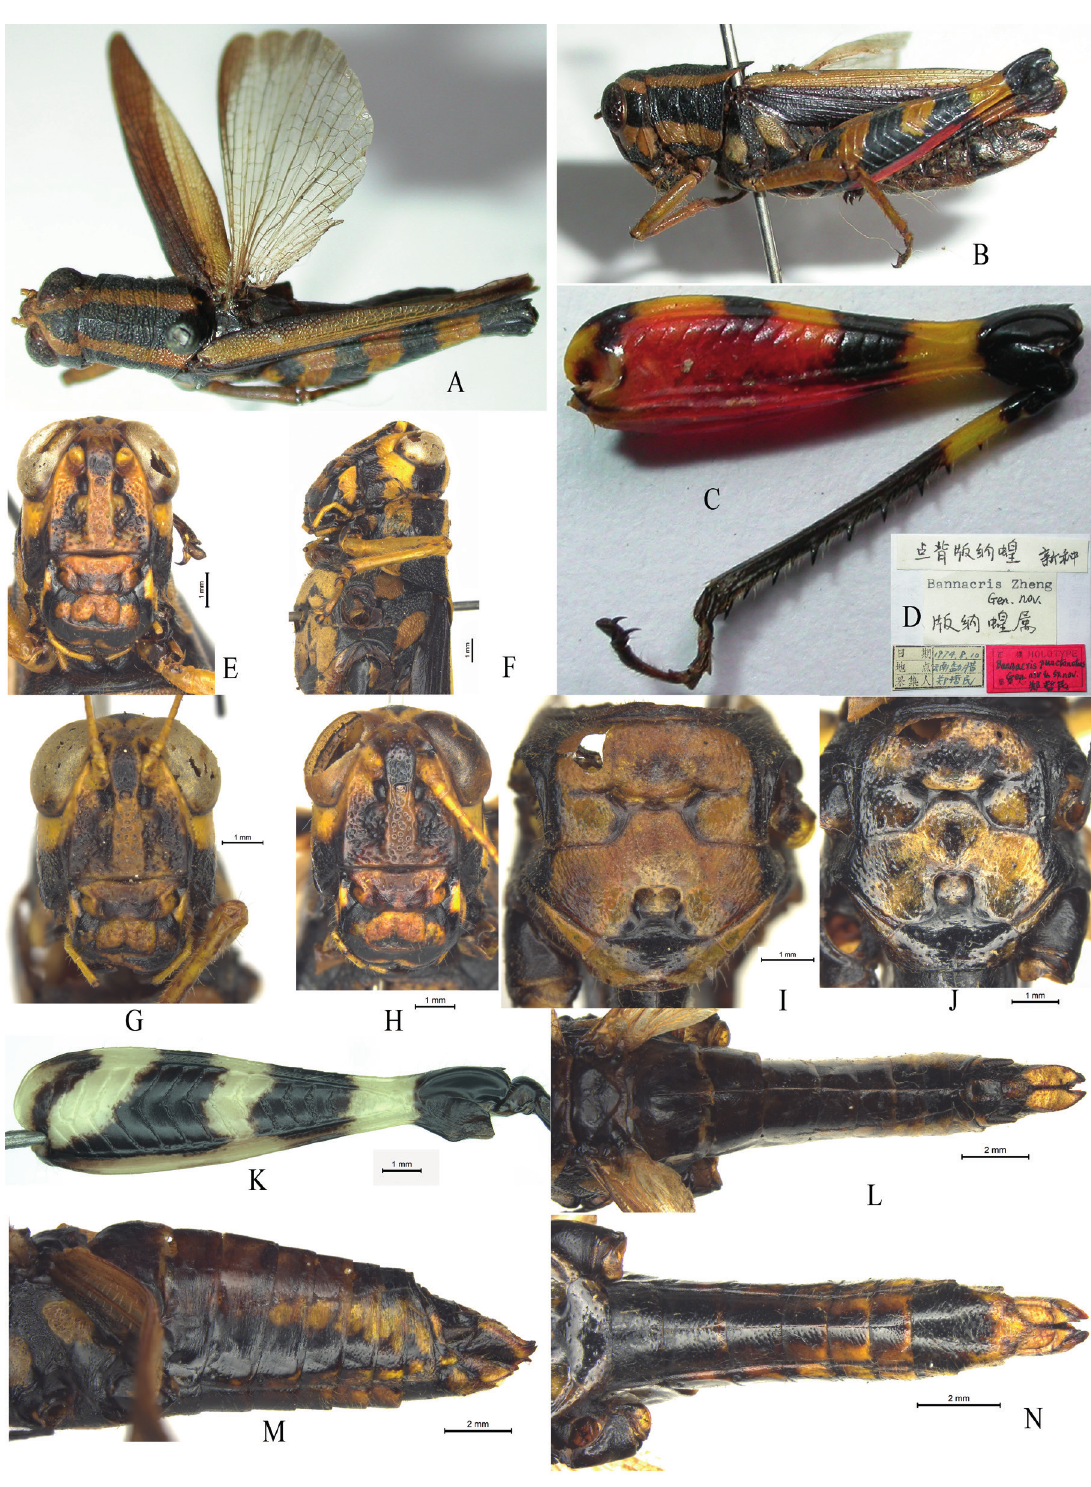
Fig. 2. ♀♀ of Bannacris punctonotus Zheng, 1980 syn. nov. (= Pseudotraulia cornuata Laosinchai & Jago, 1980). A–D . Holotype (SNU), ♀. A–B . Habitus in dorsal and lateral views. C . Inner side of hind leg. D . Labels of the holotype (SNU), ♀. E–N . Closeup of additional materials. E, G–H . Head in frontal view. F . Head and thorax in lateral view. I–J . Meso- and metasterna. K . Outer side of hind femur. L–N . Abdomen in dorsal, lateral and ventral